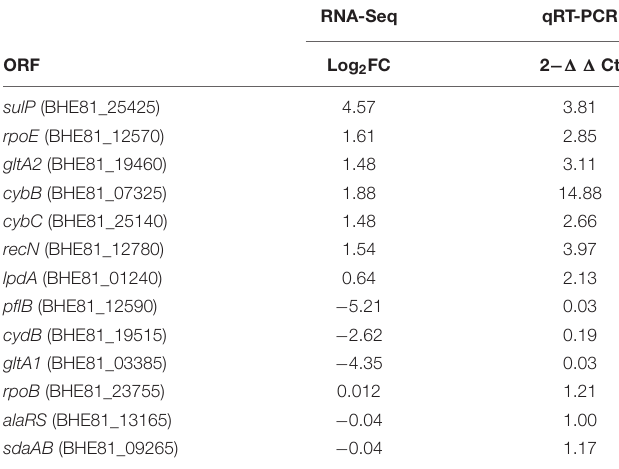
FIGURE 4 | TEM Micrographs of Klebsiella sp. strain AqSCr cells grown in (A) LB (pH 8) without Cr(VI) and (B) LB (pH 8) with 11 mM Cr(VI).